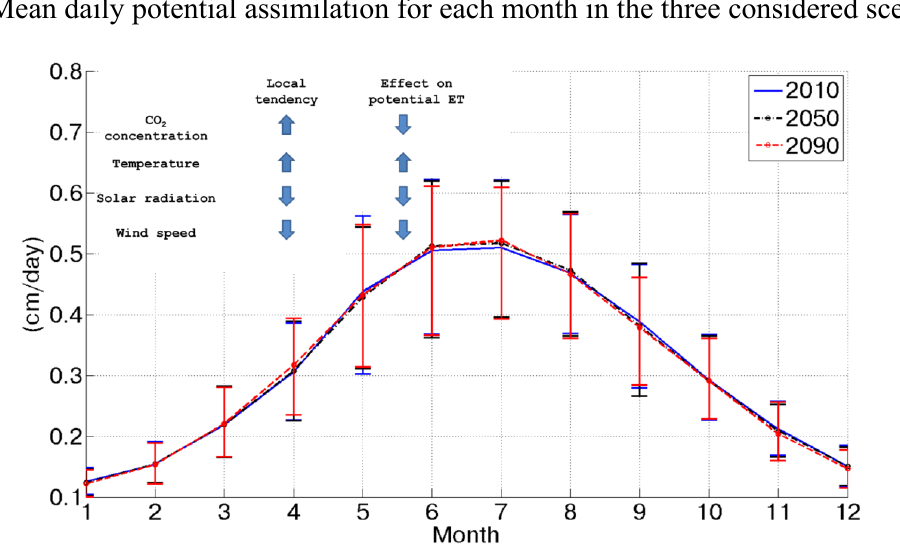
Figure 3. Mean daily potential assimilation for each month in the three considered